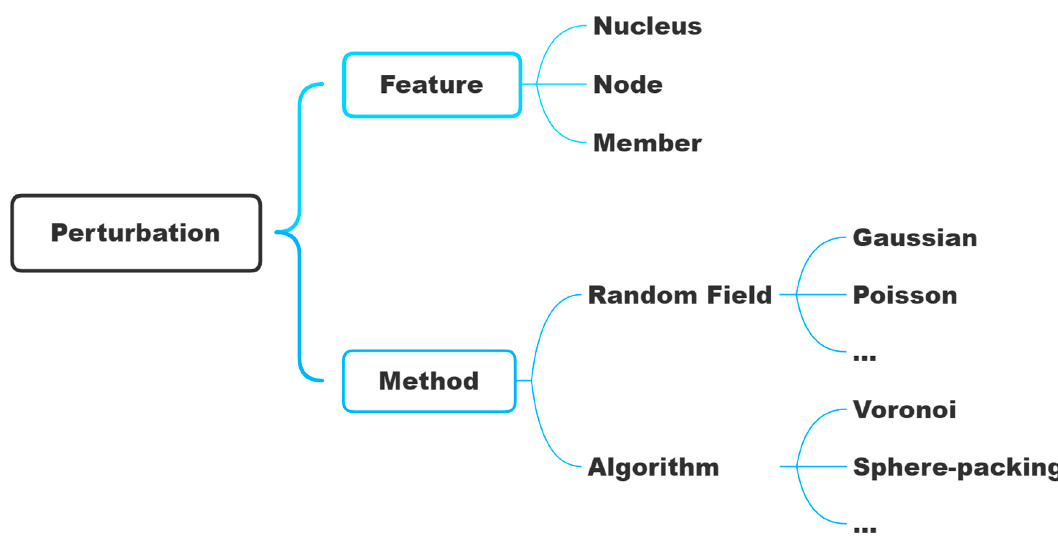
Figure 11. Classification proposed for perturbation of cellular materials, divided into two decision levels: the feature to which it is applied and the method used to define it.